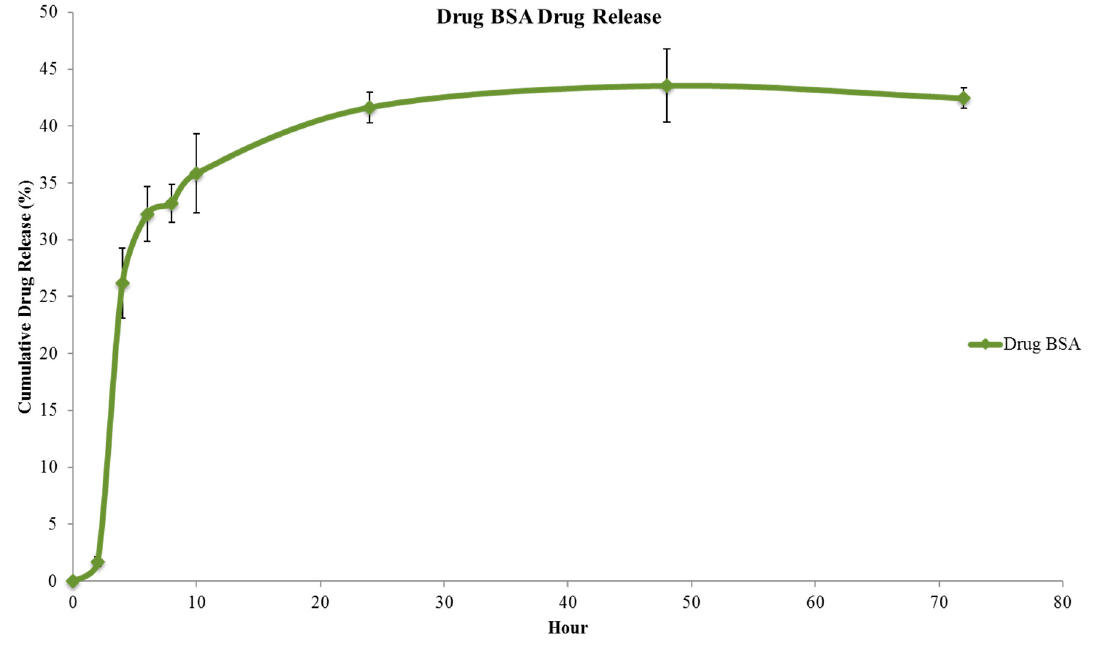
Figure 8. Time-dependent sustained release of drug from DNPs over a period of 72 h.